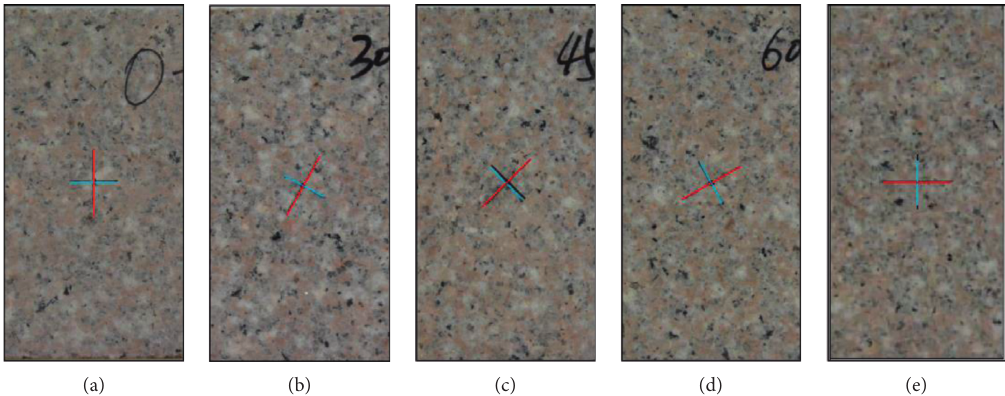
Figure 2: The granite specimens with two orthogonal cracks: (a) α � 0 ° 00–90, (b) α � 30 ° 30–90, (c) α � 45 ° 45–90, (d) α � 60 ° 60–90, and (e) α � 90 °